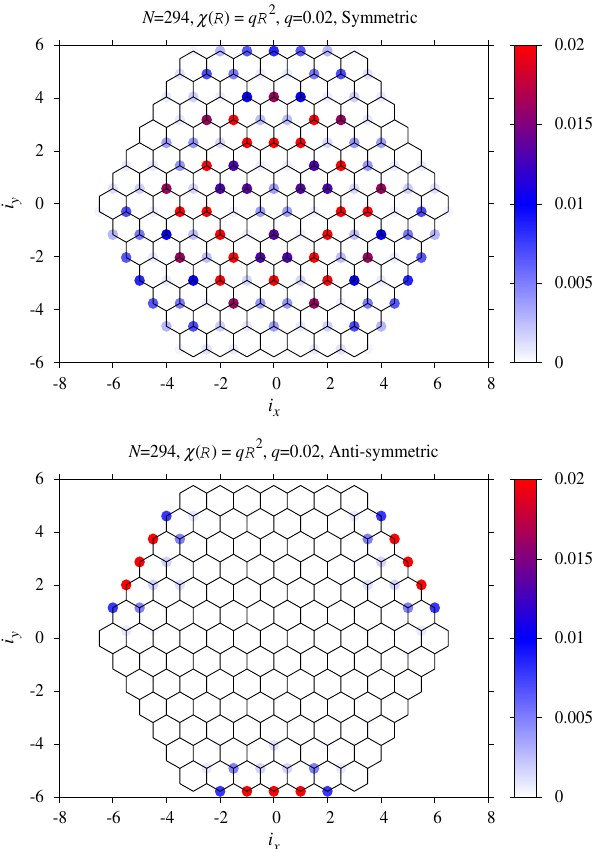
FIG. 2. Top: Spatial distribution of the symmetric combination ðj S iÞ of the wave functions j (cid:2) δ i , living on the A sublattice, in a ¼ 7 . Bottom: Spatial distribution of system of 294 sites or r max their antisymmetric combination ðj AS iÞ , living on the B sub- lattice, in the same system. The axial magnetic field is set to be uniform here; i.e., χ ð R Þ ¼ q R 2 , with q ¼ 0 . 02